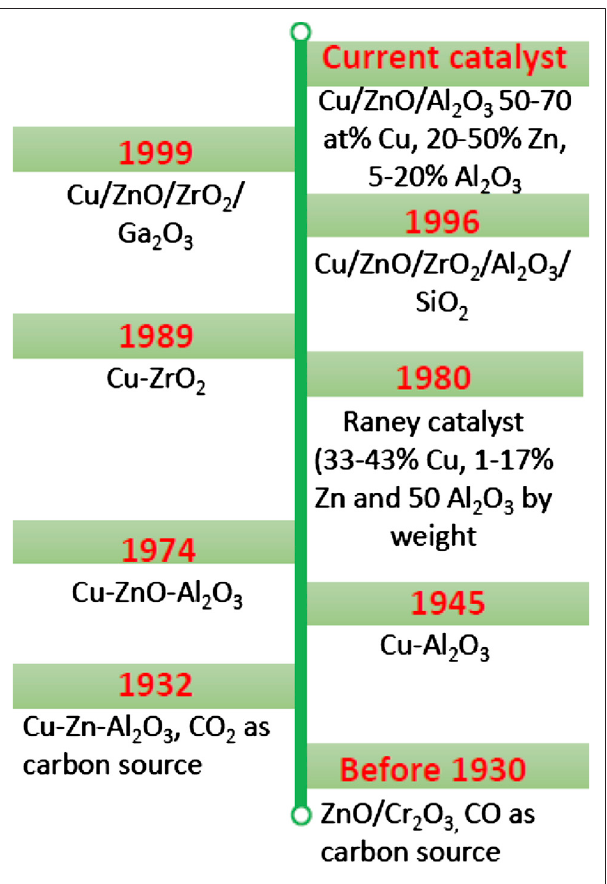
FIGURE 4 | Evolution of Cu-based catalysts for conversion of CO 2 to methanol (CO 2 as the sole carbon